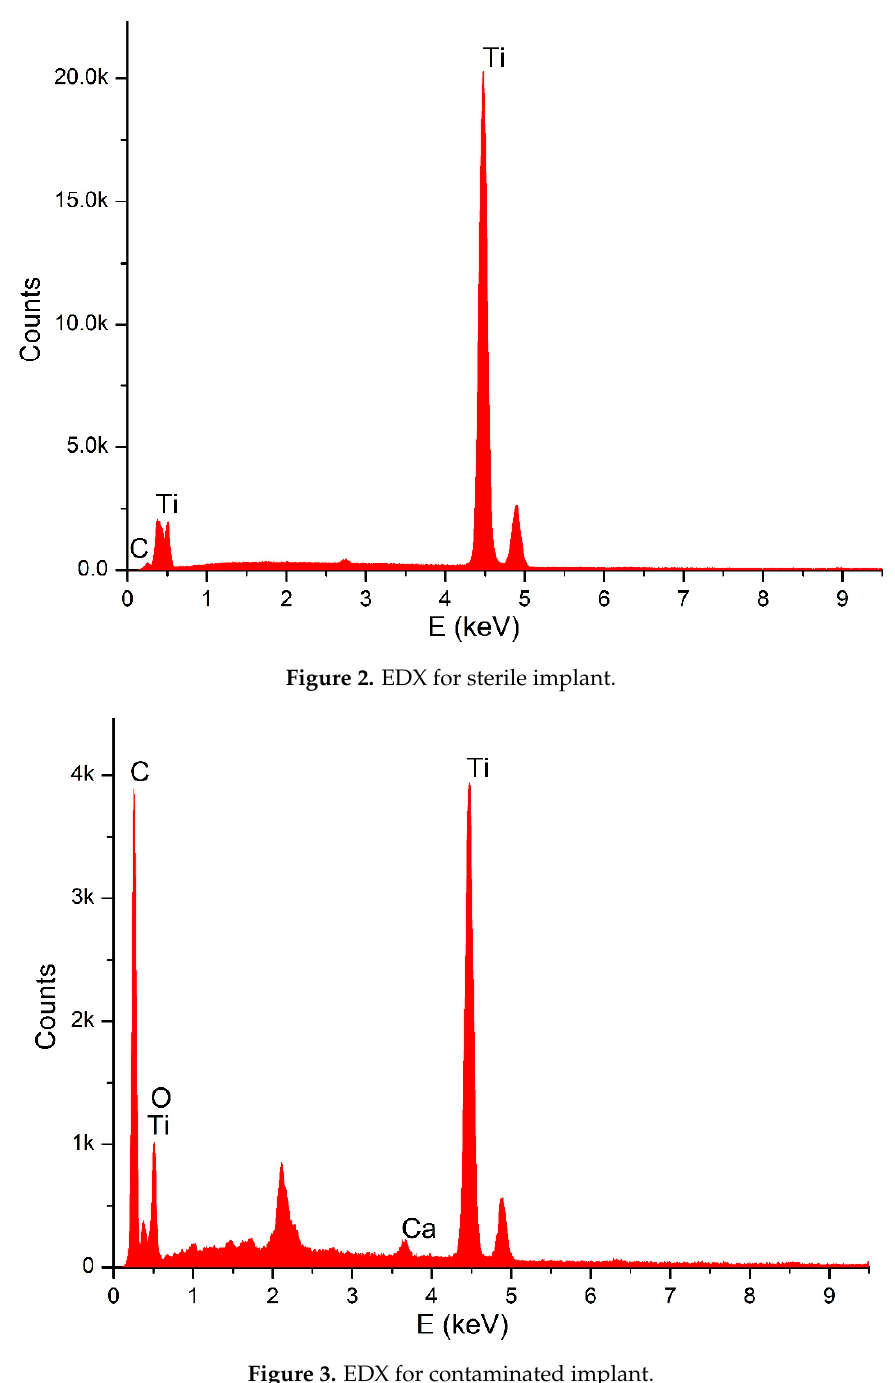
Figure 3. EDX for contaminated implant.